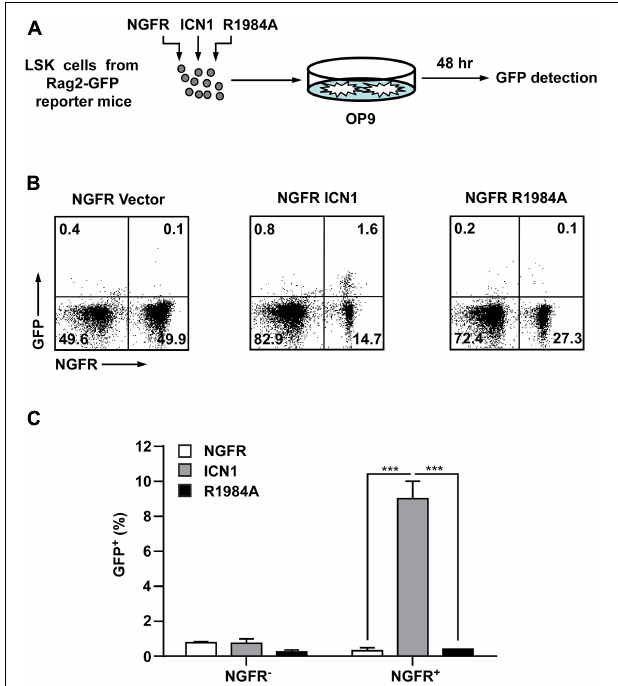
FIGURE 4 | Enforced expression of dimeric Notch1 activates the Rag2 reporter expression in hematopoietic progenitors. (A) Schematic presentation of the experimental procedure. GFP - LSK (Lin - Sca + c-Kit + ) cells derived from RAG2 -GFP reporter mice (NG-BAC) were transduced with viruses expressing ICN1 or R1984A with NGFR as surrogated marker. The infected cells were co-cultured with stromal cells OP9 for 48 h and then measured the GFP + percentage as an indication of Rag2 expression. (B) Flow cytometry analysis of GFP and NGFR-PE expressions in hematopoietic cells recovered from OP9 culture. (C) A histogram presentation of GFP + cell percentages in NGFR-negative or NGFR-positive populations in panel (B) . *** p <